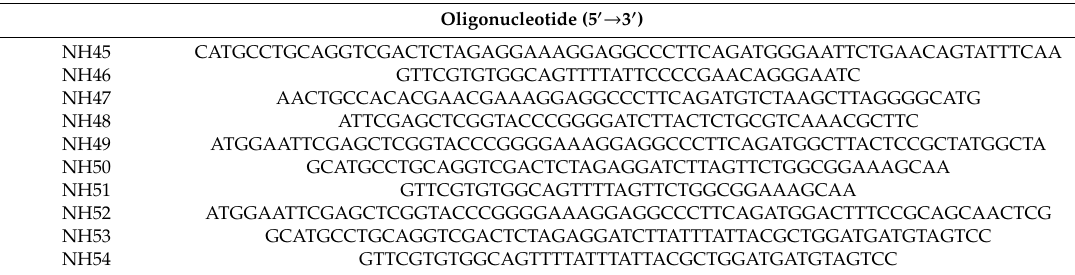
Table 2. Oligonucleotides used in this